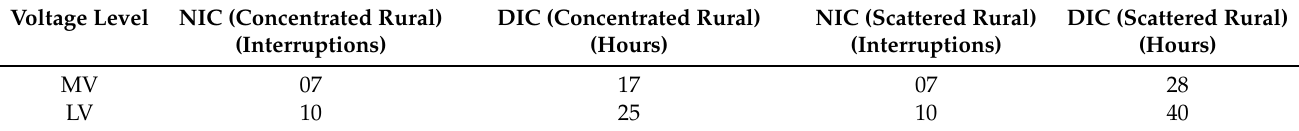
Table 11. Tolerance limits for indicators in Peru for rural areas.